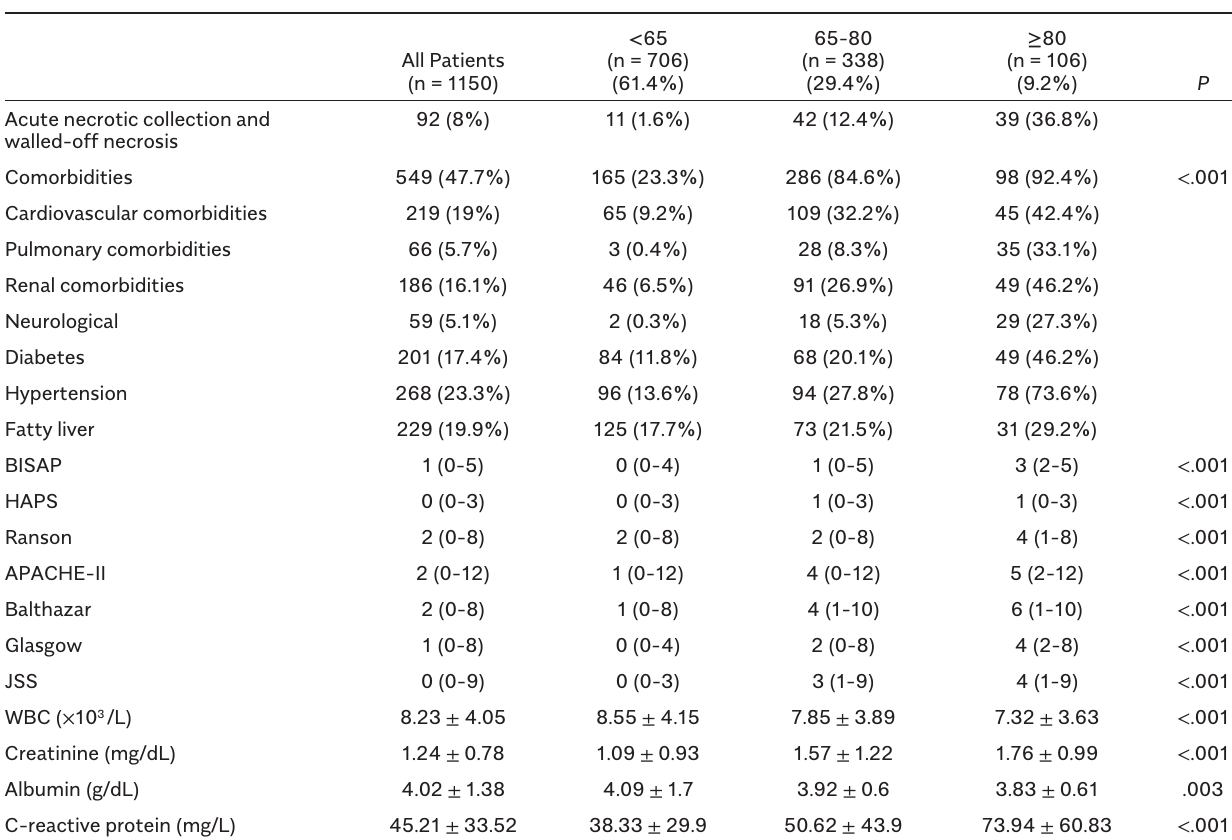
Table 1. Demographic, Clinical Characteristics, and Investigated Laboratory Parameters and Results of Scoring Systems in Patients Aged Over 65 Years and 80 Years ( Continued